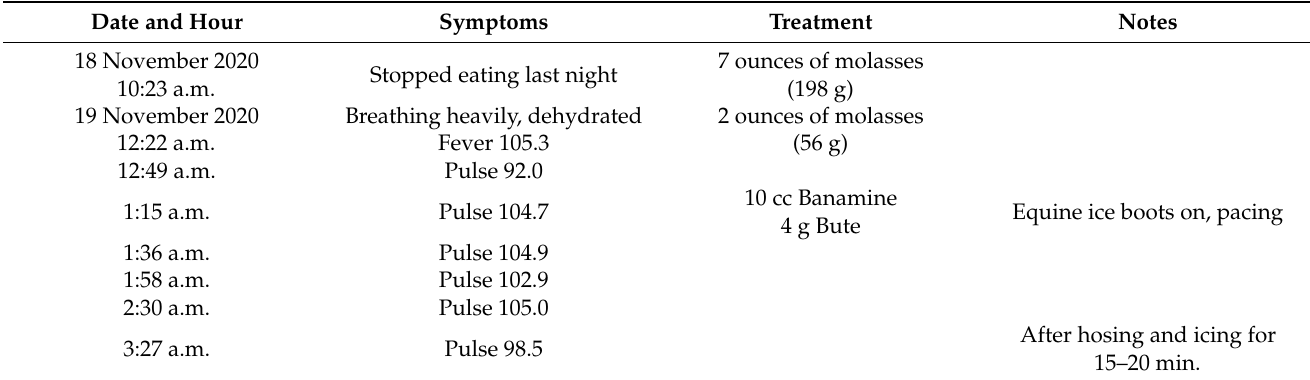
Table 1. Veterinary transcript, owner’s notes, and treatment for the late horse Serena two days before death. Hawaii Polo Club and Hawaii Polo Trail Rides data. Source: unpublished diagnostic report,